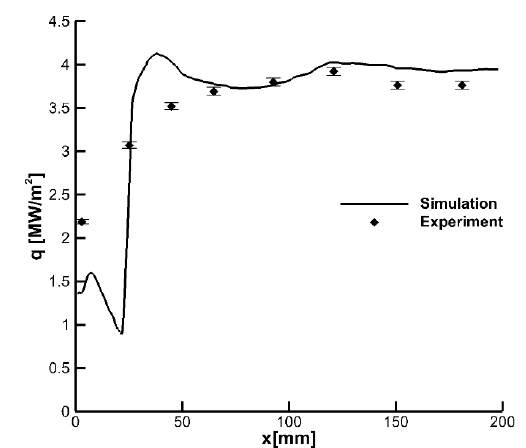
Figure 12. Heat flux density profile for the simulation and experiment result.